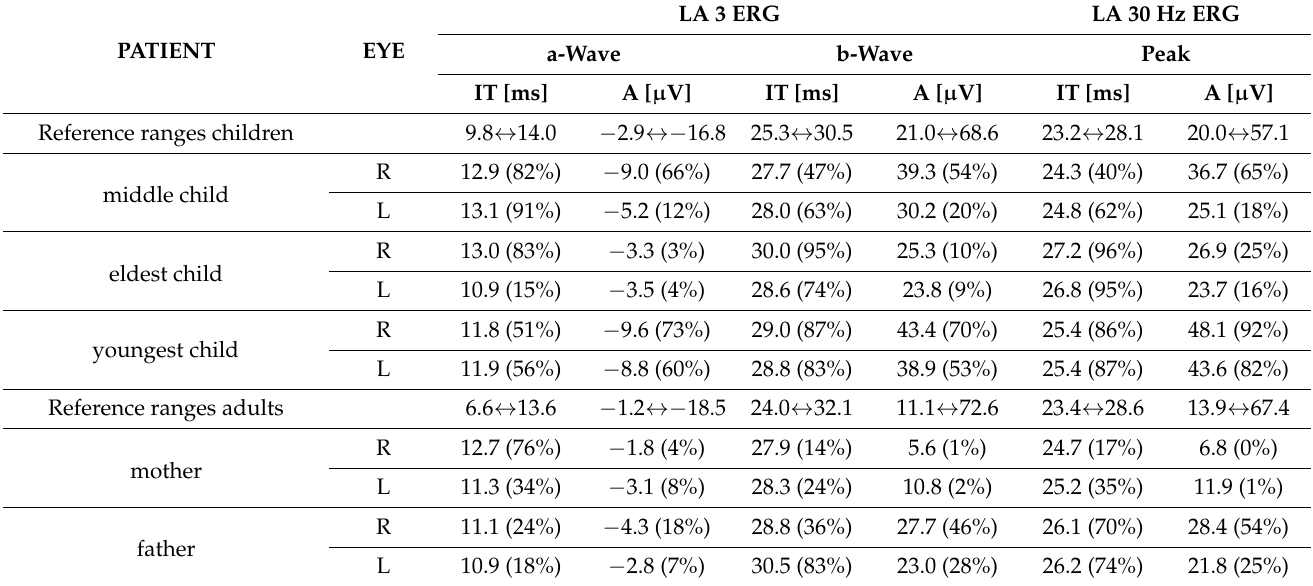
Table 2. The photopic ffERG performed in August in the year of arLHON diagnosis. LA—light adapted; IT—implicit time; A—amplitude; R—right; L—left. Reference ranges according to LKC. Values in parentheses are